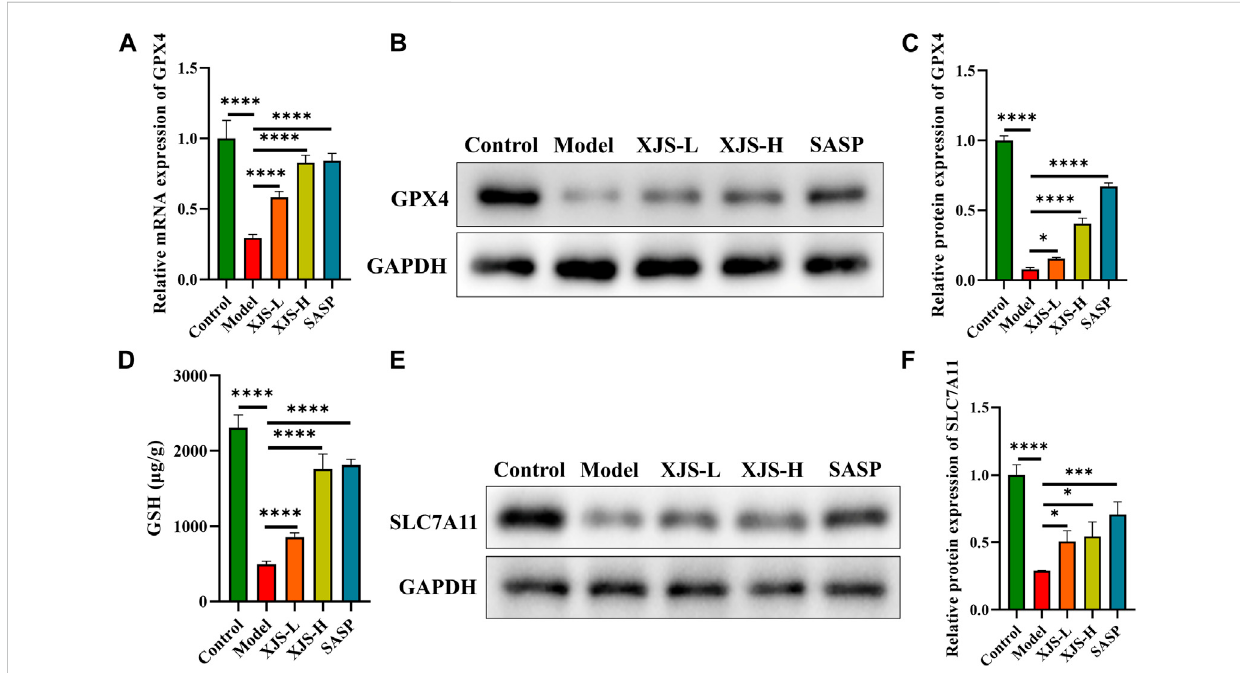
FIGURE 6 XJS enhanced SLC7A11/GSH/GPX4 antioxidant axis. (A) The mRNA expressions of GPX4 ( n = 6). (B, C) The protein expressions of GPX4 (n = 3). (D) The levels of GSH ( n = 3). (E, F) The protein expressions of SLC7A11 ( n = 3). * p < 0.05, *** p < 0.001, **** p <